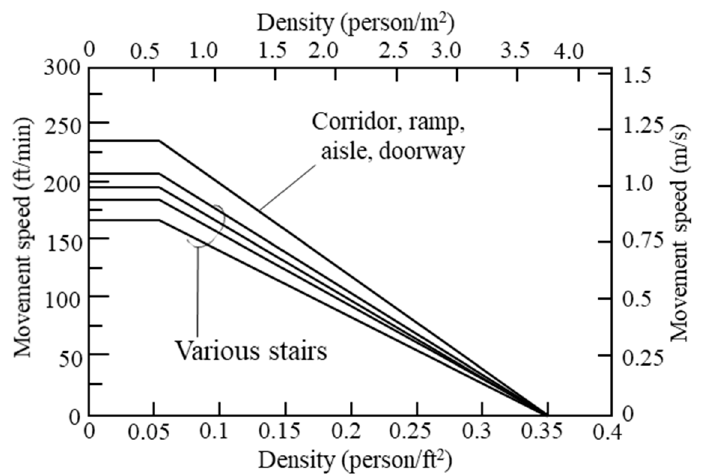
Figure 2. Evacuation speed as a function of